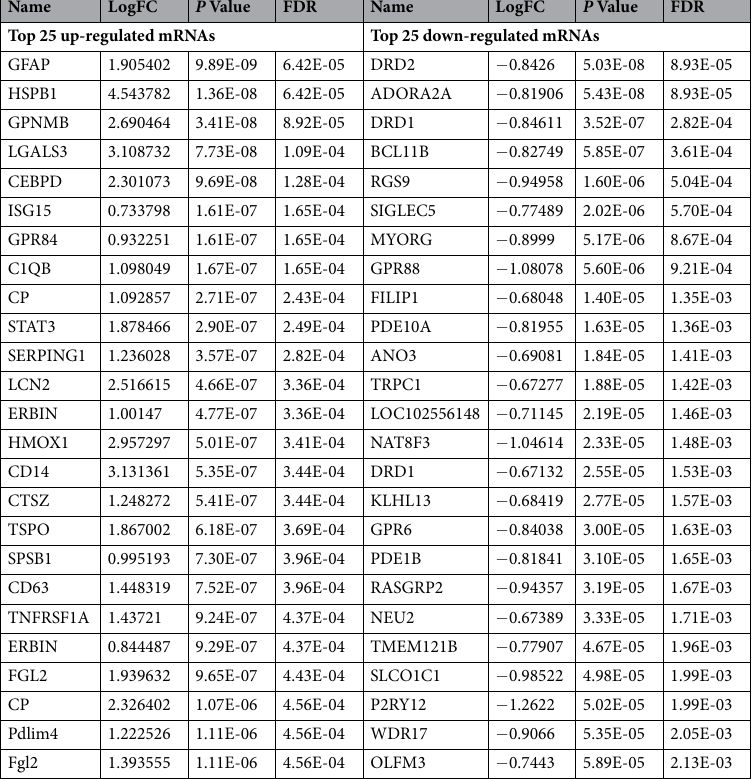
Table 3. Top 50 differentially expressed mRNAs, half up-regulated, half down-regulated, in CI samples.